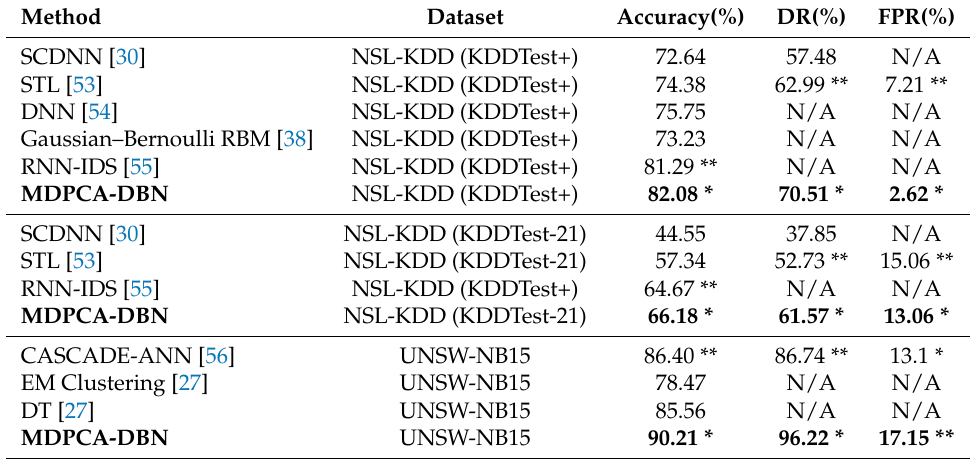
Table 13. Comparison results based on NSL-KDD and UNSW-NB15 datasets (N/A means no available results, * Ranked first, ** Ranked